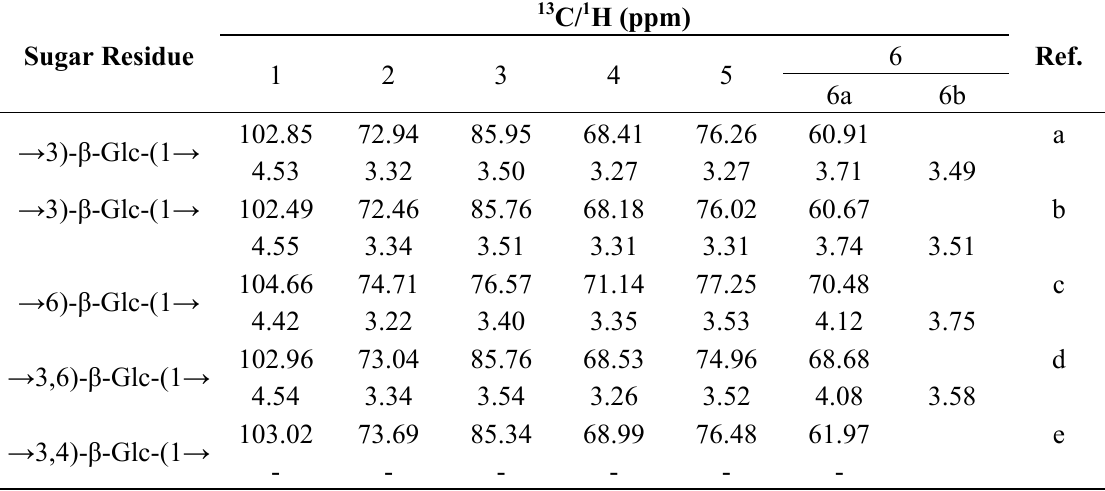
Table 1. The assignments of 13 C NMR and HSQC spectrum.